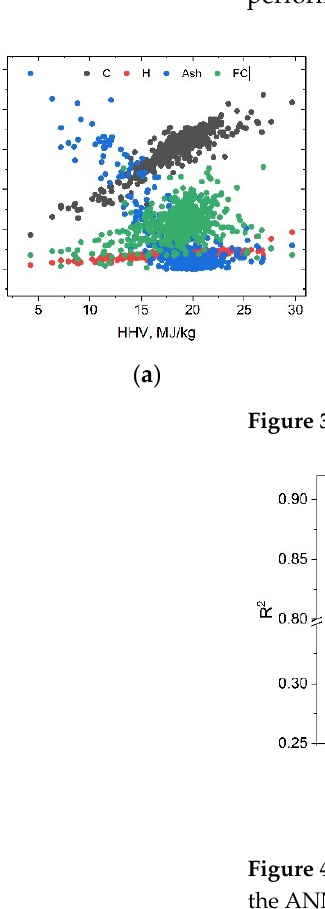
( b ) Figure 2. HHV before ( a ) and after ( b ) randomization. The next step of data preprocessing involved normalization (2) and centralization (3) of the input dataset. Both procedures ensure the heterogeneity of input parameters, so the ANN takes them into account to an equal extent. 𝑋 (cid:3046)(cid:3030)(cid:3028)(cid:3039)(cid:3032)(cid:3031) = 𝑥 − 𝑥. 𝑚𝑖𝑛 𝑥. 𝑚𝑎𝑥 − 𝑥. 𝑚𝑖𝑛 (𝑚𝑖𝑛 − 𝑚𝑎𝑥) + 𝑚𝑎𝑥,